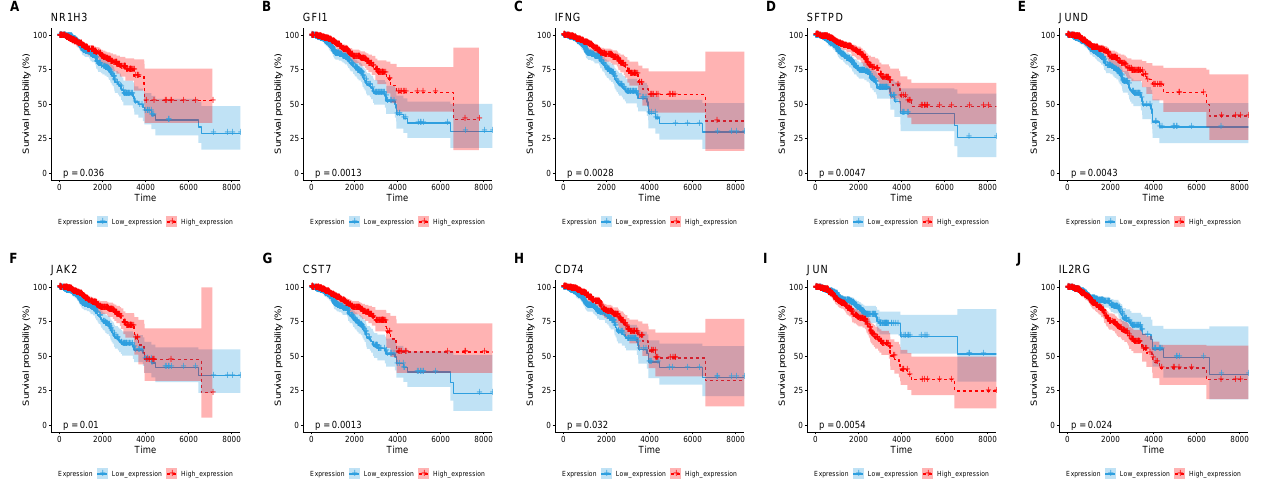
Figure 7. Of the 16 phagocytosis regulators, 10 genes had significant prognostic differences between the samples grouped by the median expression level of high and low expression. ( A ) NR1H3 ; ( B ) GFI1 ; ( C ) IFNG ; ( D ) SFTPD ; ( E ) JUND ; ( F ) JAK2 ; ( G ) CST7 ; ( H ) CD74 ; ( I ) JUN ; ( J ) IL2RG